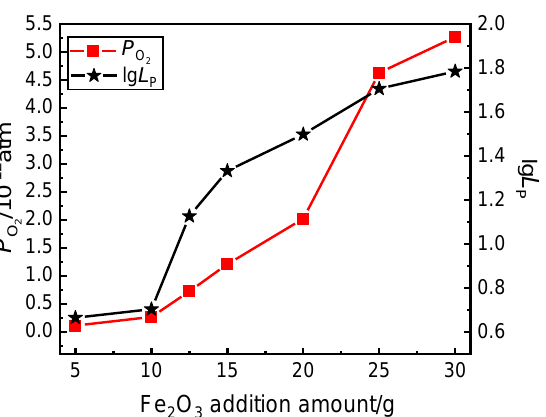
calculated as well as L P with the Fe 2 O 3 addition amount at the end of 2